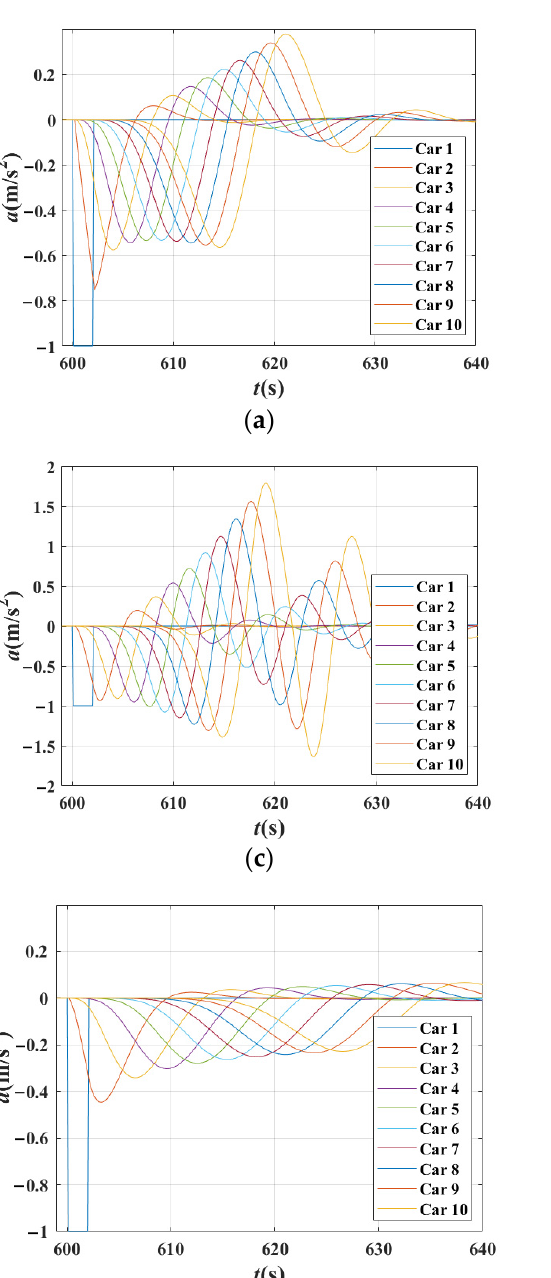
Figure 7. Time–position of the traffic when the basic model is the FVD, OV mode, and ACC model. ( a ) Time–position of the traffic when basic model is the FVD and β 1 = 0, β 2 = 0, ∆ x = 20 m; ( b ) Time–position of the traffic when basic model is the FVD and β 1 = 0, β 2 = 0.8, ∆ x = 20 m; ( c ) Time–position of the traffic when basic model is the OV model and β 1 = 0., β 2 = 0, ∆ x = 20 m; ( d ) Time–position of the traffic when basic model is the OV model and β 1 = 0.8, β 2 = 0, ∆ x = 20 m; ( e ) Time– position of the traffic when basic model is the ACC model and β 1 = 0.0, β 2 = 0, t hw = 2.5 s ACC; ( f ) Time–position of the traffic when basic model is the ACC model and β 1 = 0.8, β 2 = 0.0, t hw = 2.5 s.